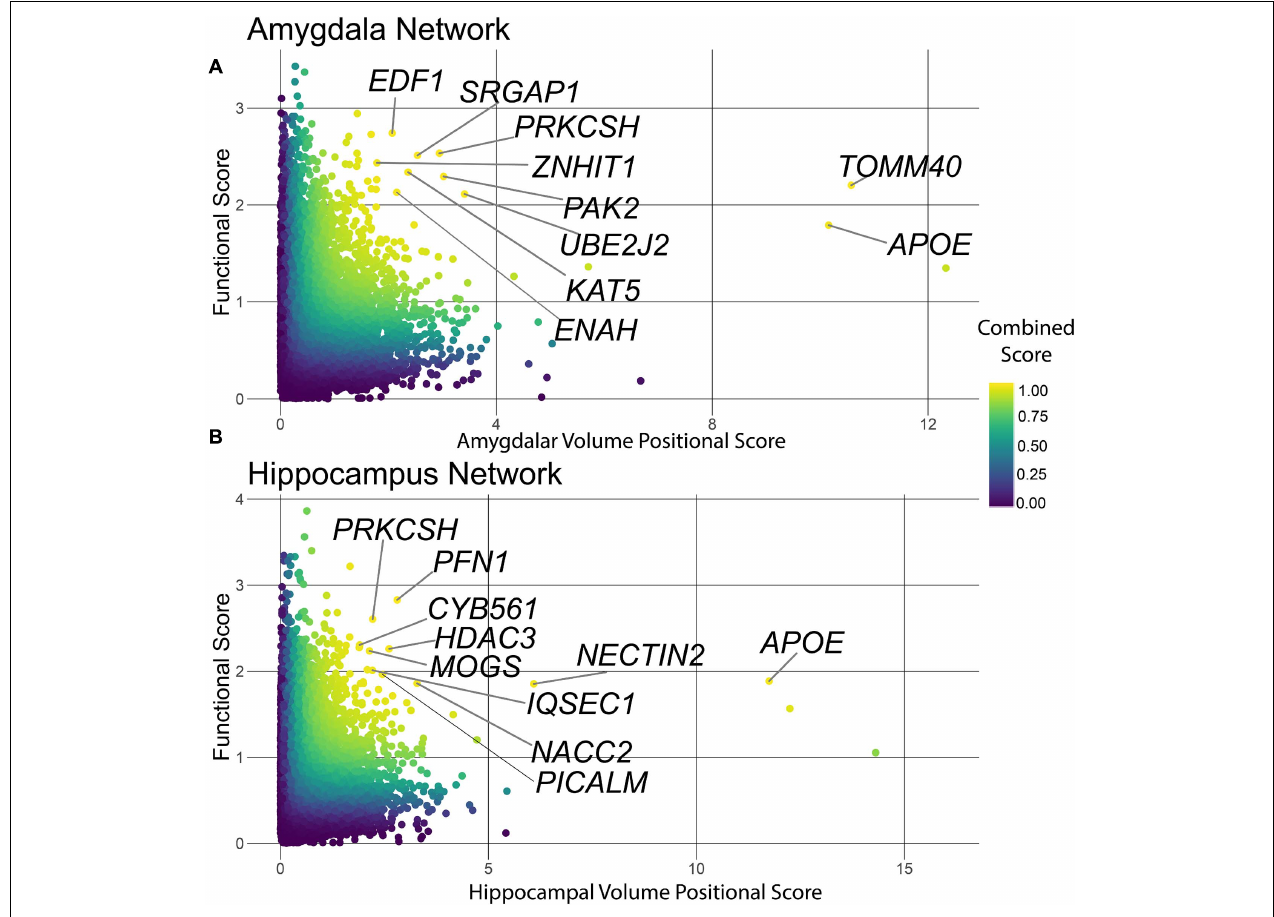
FIGURE 4 | Combined score ranking. Points are colored on a gradient by combined score with yellow points scoring highest, and blue points scoring lowest. (A) The combined score plot for the amygdala tissue. Several of the top ranked genes were involved in the regulation gene transcription ( EDF1 ) or the maintenance of organelles ( PRKCSH, UBE2J2 ) and integrity of the synapse ( PAK2, ENAH ). (B) The combined score plot for the hippocampus tissue. Several genes were involved in processes required for the maintenance of the synapse ( PFN1, IQSEC1 ) regulation of gene transcription ( HDAC3 ) and proper ER regulation ( PRKCSH, MOGS